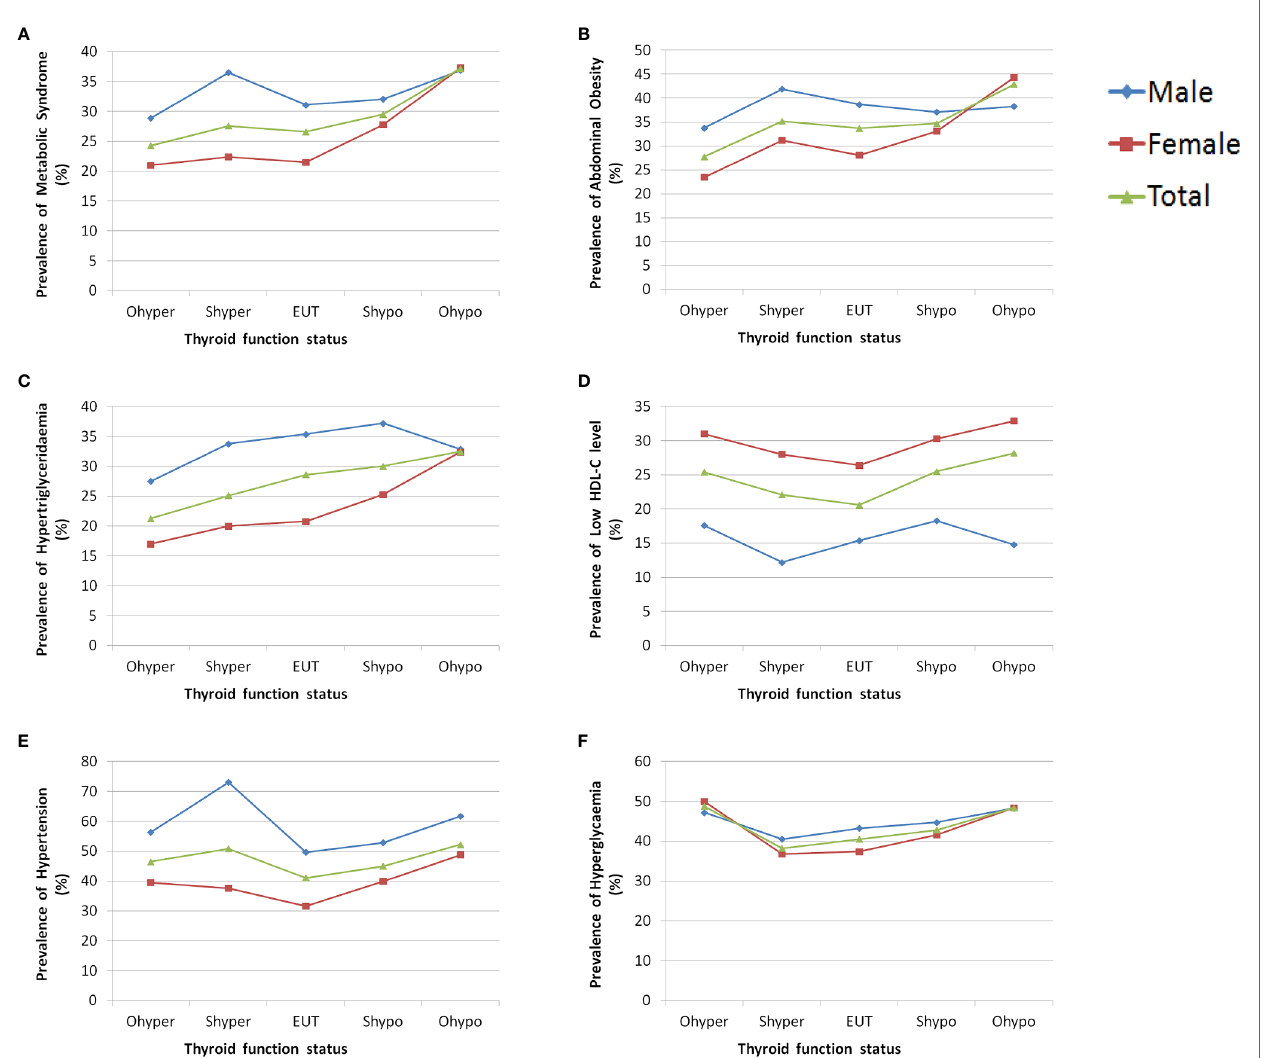
FIGURE 2 | The prevalence of metabolic syndrome and each of its component in different thyroid function status groups by sex. (A) Prevalence of metabolic syndrome grouped by sex. (B) Prevalence of abdominal obesity grouped by sex. (C) Prevalence of hypertriglyceridemia grouped by sex. (D) Prevalence of low HDL-C grouped by sex. (E) Prevalence of hypertension grouped by sex. (F) Prevalence of hyperglycaemia grouped by